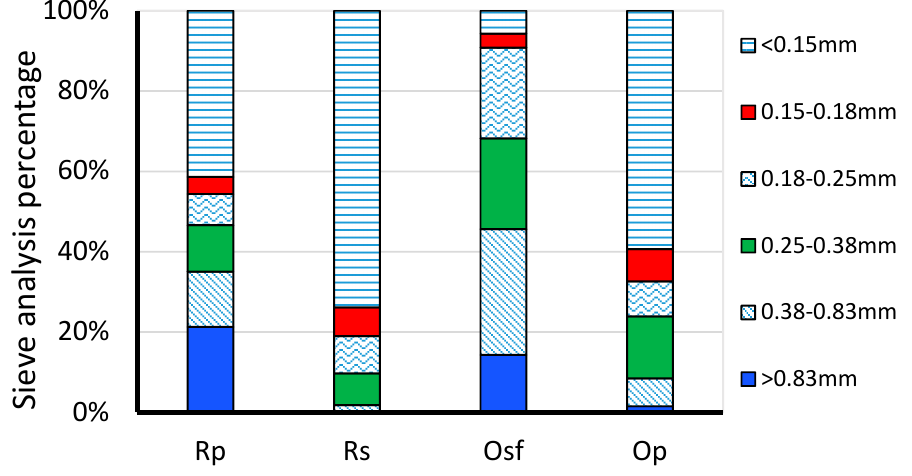
Figure 1. Particle size distributions of various materials. Rp—rice straw particles; Rs—rice strawboard sanding powders; Osf—oriented strandboard (OSB)screened-out fines; Op—OSB sanding powders.